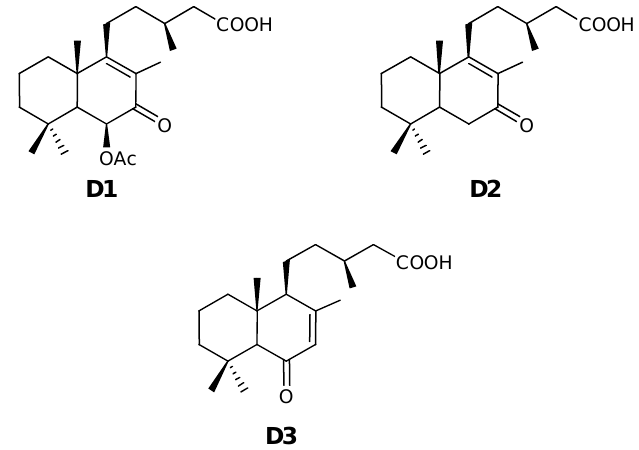
Figure 1. Chemical structures of diterpenes in the exudate of C. ladanifer